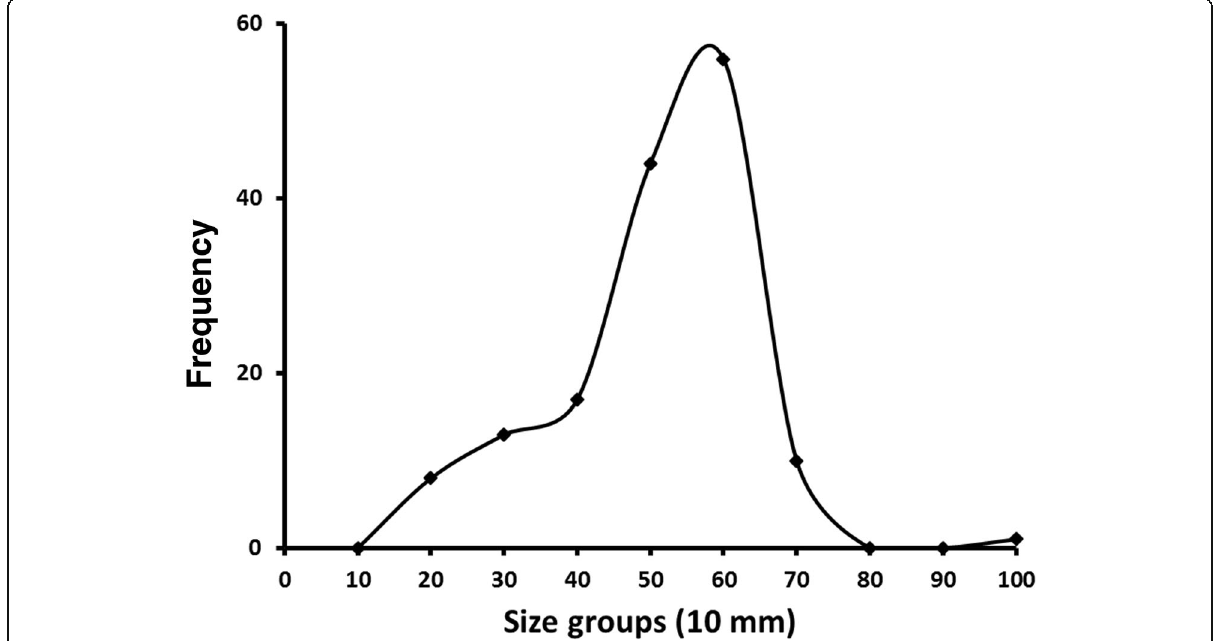
Fig. 2 Size frequency distribution of Pila globosa sampled from different locations of India